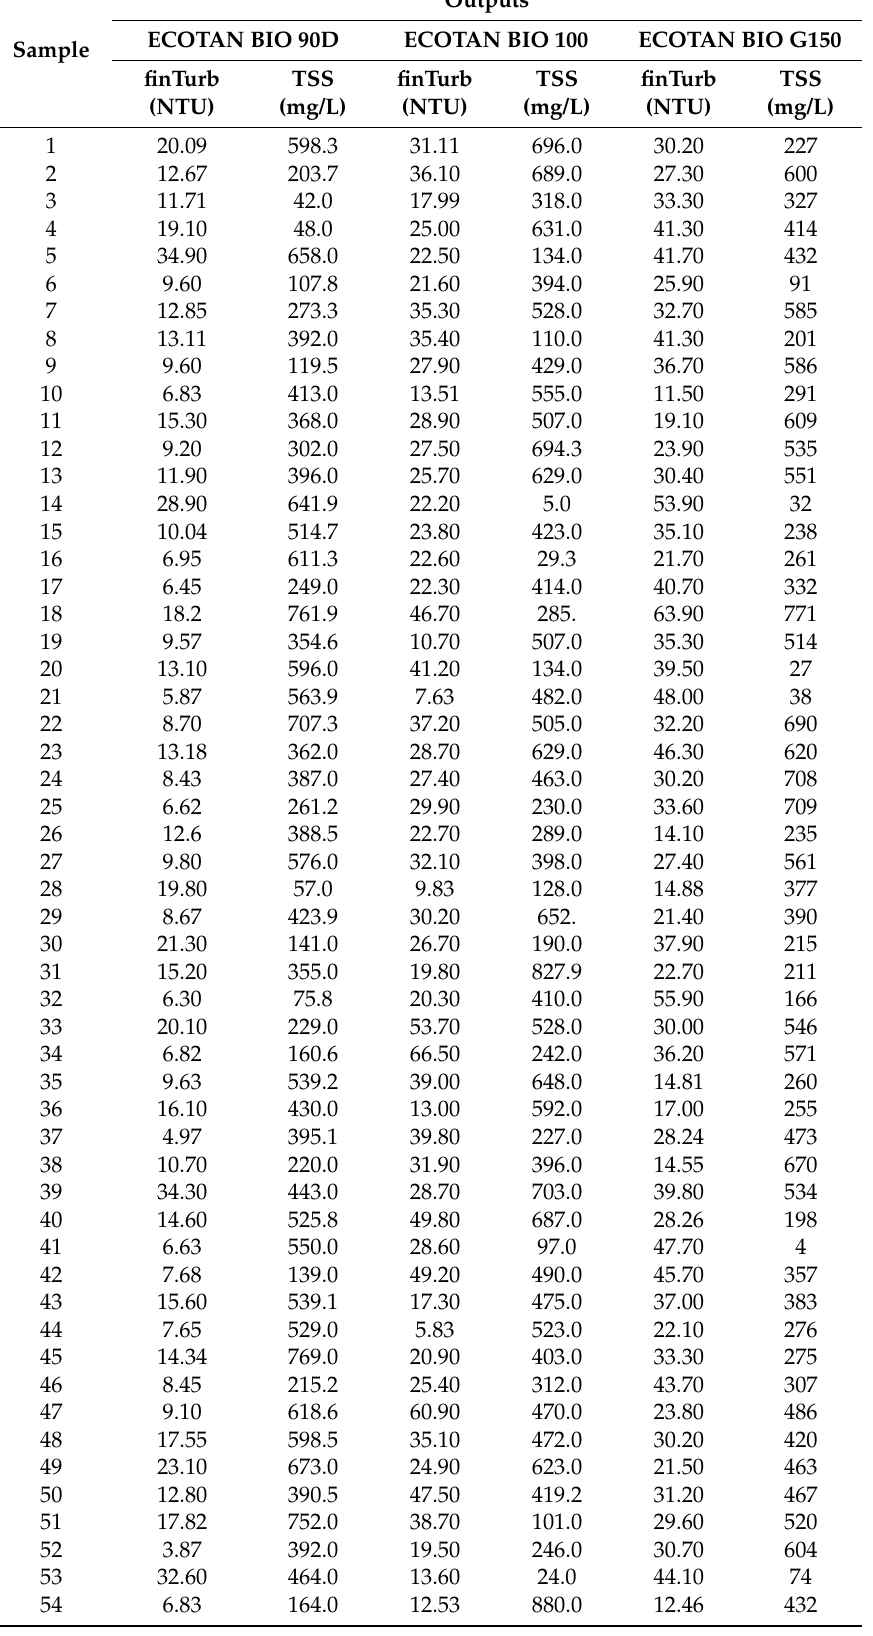
Table 4. Experimental design matrix for the clarification process in waste water